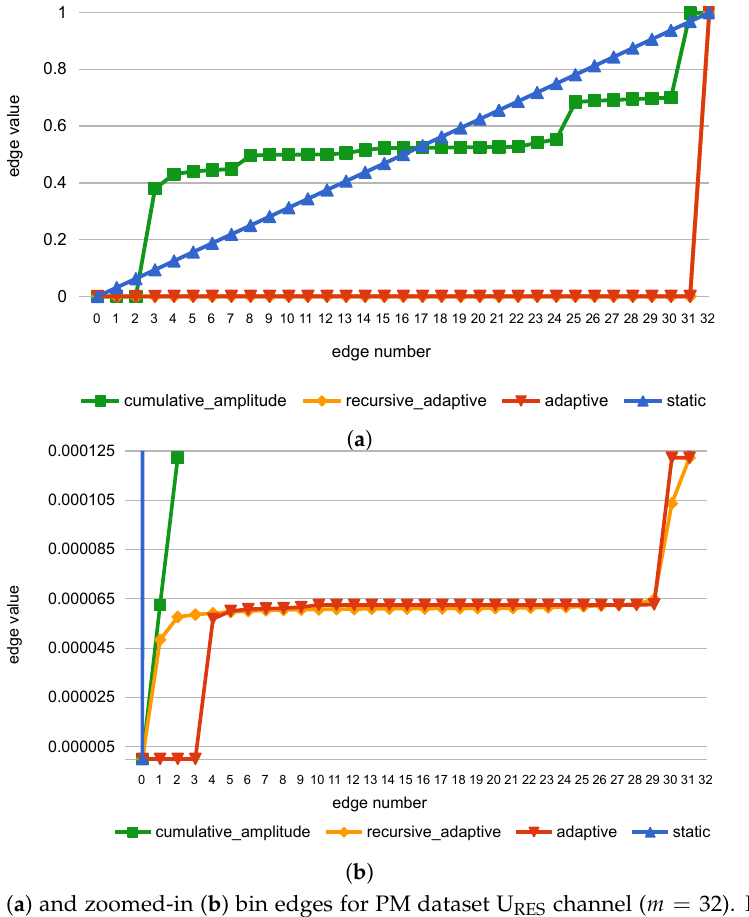
Figure 5. Full ( a ) and zoomed-in ( b ) bin edges for PM dataset U RES channel ( m = 32). Please note that adaptive quantization algorithm effectively yields only 10 bins, since some edges values occur multiple